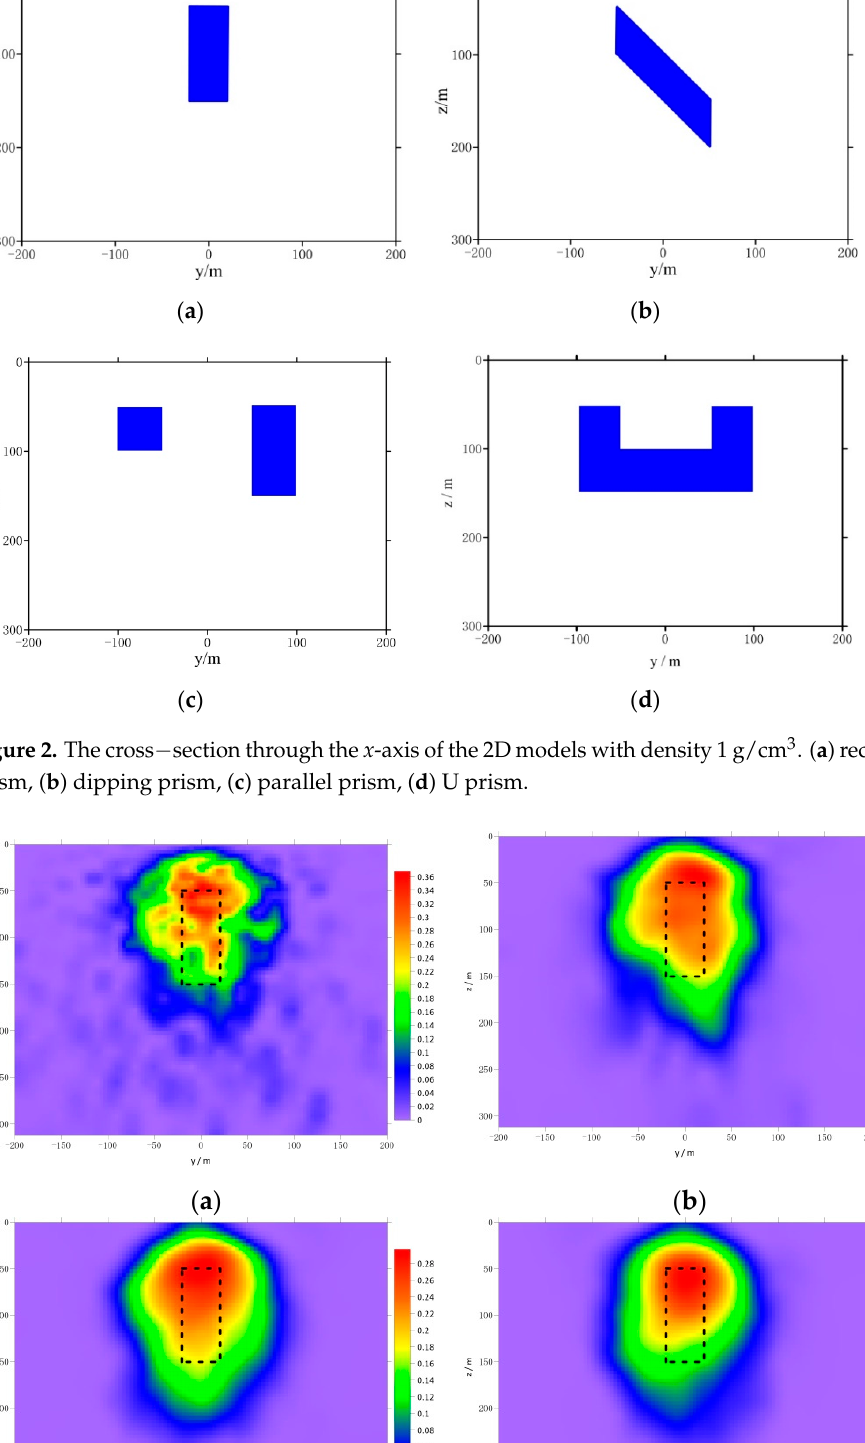
Figure 2. The cross − section through the x -axis of the 2D models with density 1 g/cm 3 . ( a ) rectangular prism, ( b ) dipping prism, ( c ) parallel prism, ( d ) U prism.